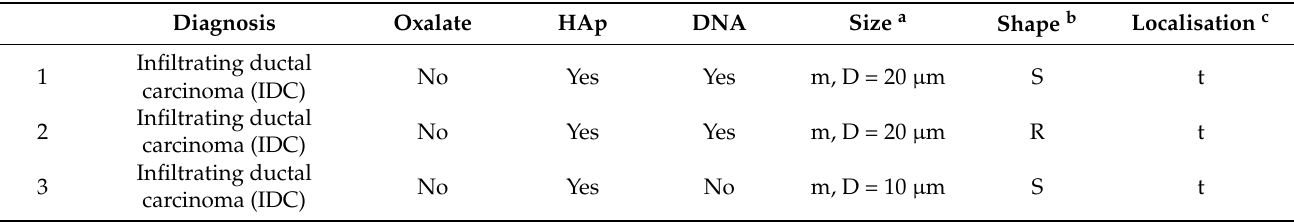
Table 1. Summary of the microcalcifications measured by Raman spectroscopy found in the human breast cancer tissue sections analyzed. For each calcification, we specify the diagnosis, the type (Oxalate or HAp), content of DNA (according to Raman spectroscopy results), size, shape, and